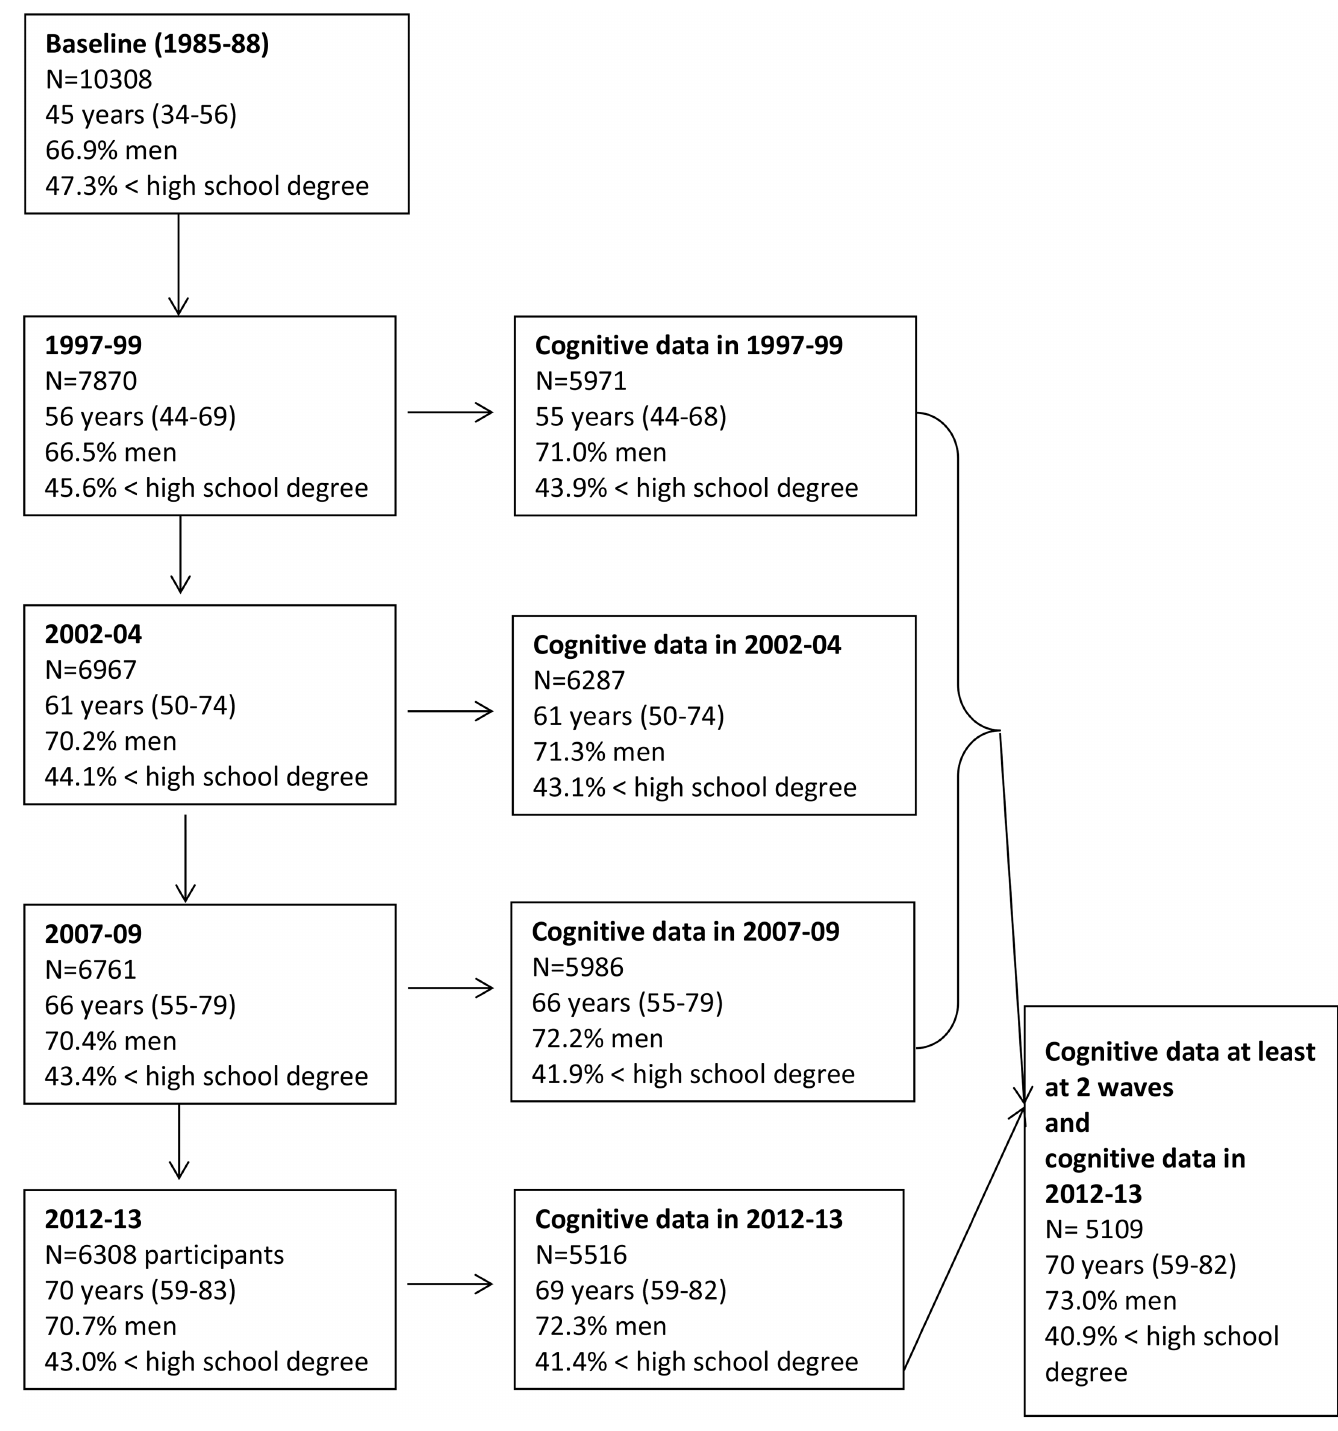
Fig 1. Sample selection, Whitehall II Study.